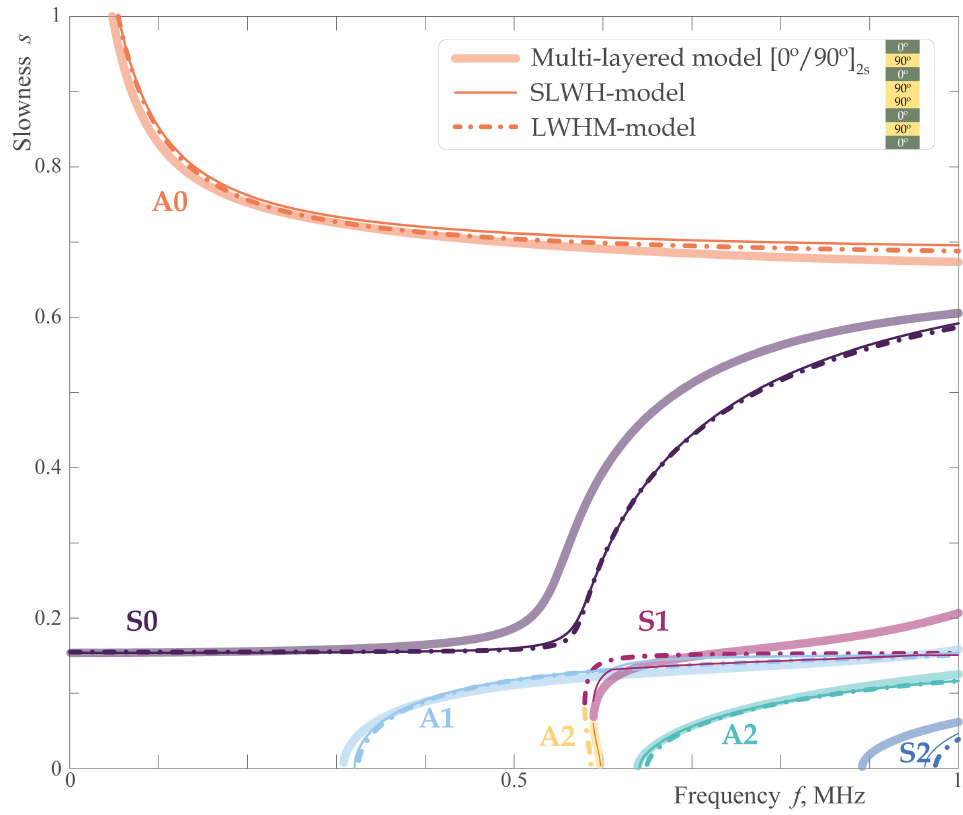
Figure 4. Slownesses s n ( f ) for [ 0 ◦ ,90 ◦ ] 2s : multi-layered waveguide (thick solid lines), homogenized waveguides (dashed and thin solid